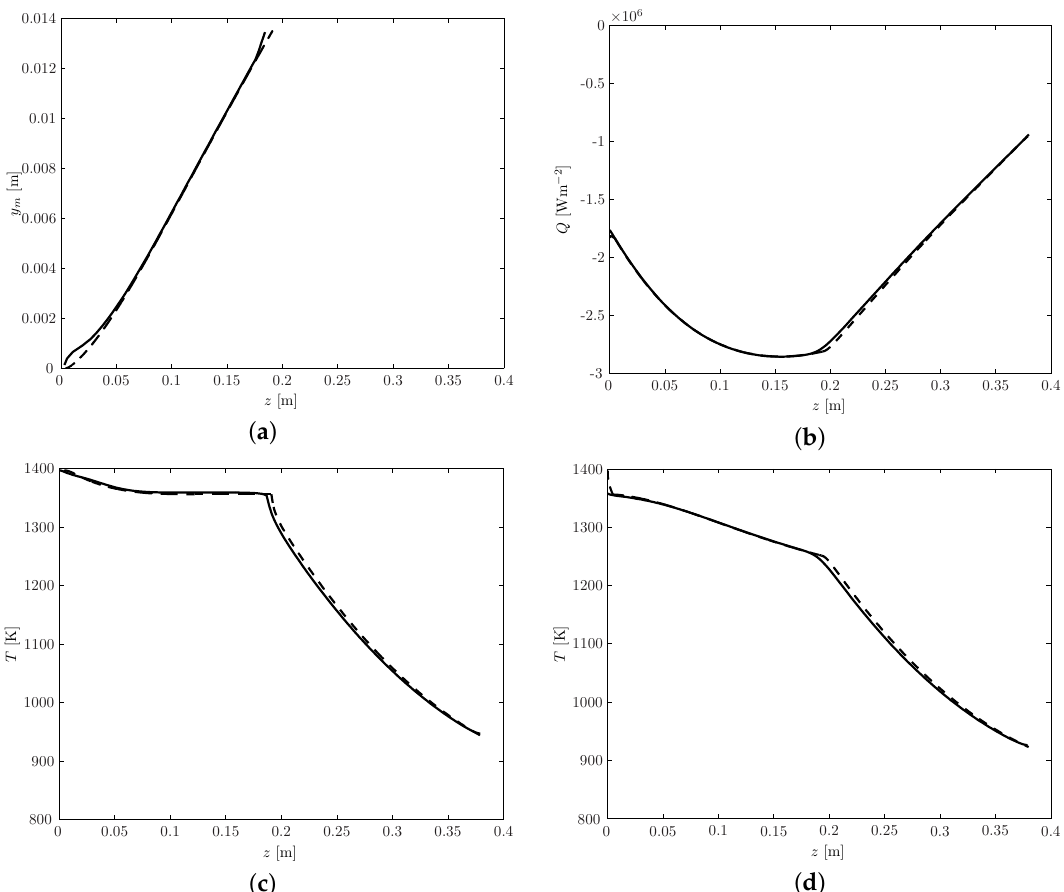
Figure 3. Comparison of: ( a ) the location of the solidification front, y m ; ( b ) the heat flux, Q , at the outer edge of the copper strip; ( c ) the temperature at the centreline ( y = W ); and ( d ) the temperature at the outer edge of the copper strip. In all cases, the solid line is for the full model, and the dashed line is for the reduced model; z denotes the distance along the casting direction from the meniscus. Reproduced from [21], with copyright permission from Elsevier,